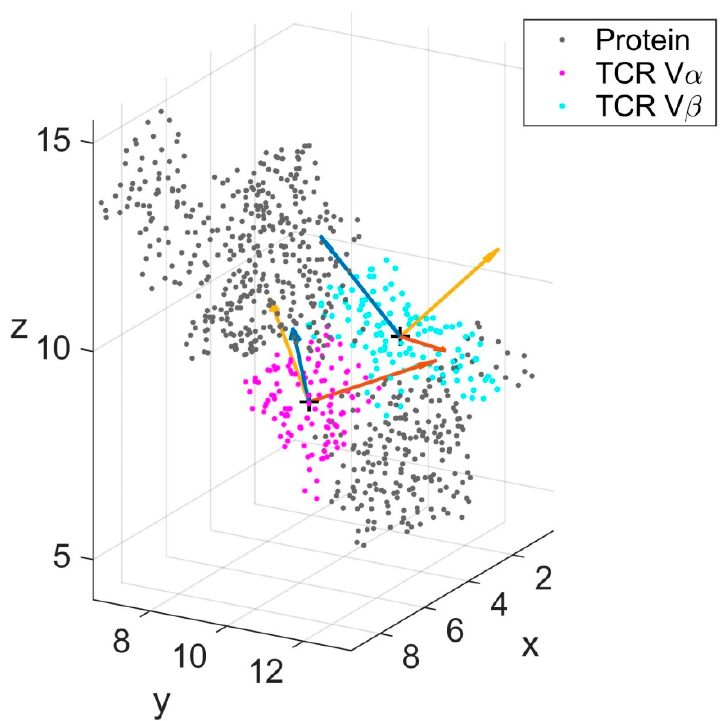
Figure 2. Schematic representation of TCR V α (magenta) and TCR V β (cyan) with local eigenvectors. The remaining parts of the complex (labelled Protein) are shown in gray. Eigenvectors ( v 1 , v 2 , v 3 and w 1 , w 2 , w 3 ) are displayed for a single frame of the trajectory and colored blue ( v 1 , w 1 ), orange ( v 2 , w 2 ) and yellow ( v 3 , w 3 ). Units of the coordinate axes are in nm.